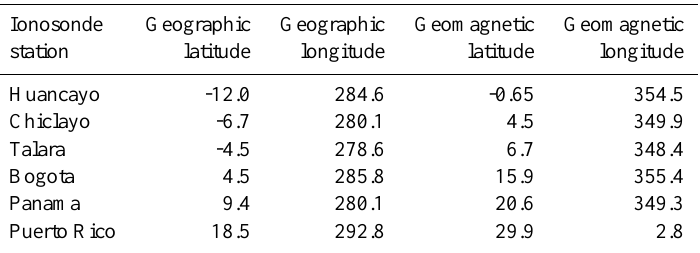
Table 1. Ionosonde station names and locations Ionosonde Geographic Geographic Geomagnetic Geomagnetic station latitude longitude